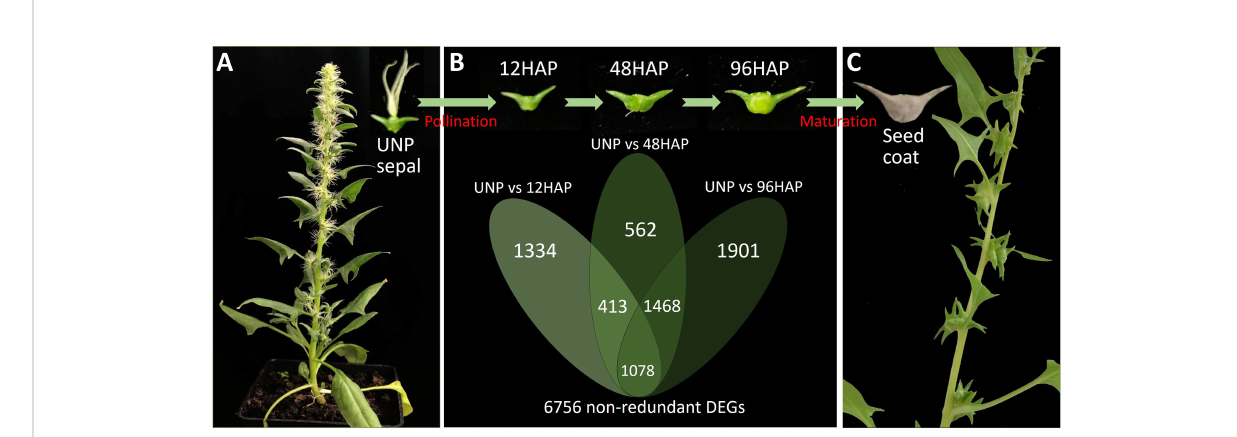
FIGURE 1 Sepal development and gene expression changes in spinach female plant before and after pollination. (A) Un-pollinated female fl owering plants (UNP). (B) Venn diagram of DEGs (differentially expressed genes) in sepals at different development time points after pollination (12, 48, 96HAP) in comparison with un-pollinated fl ower sepals (UNP). (C) Seed coat formation and fruit